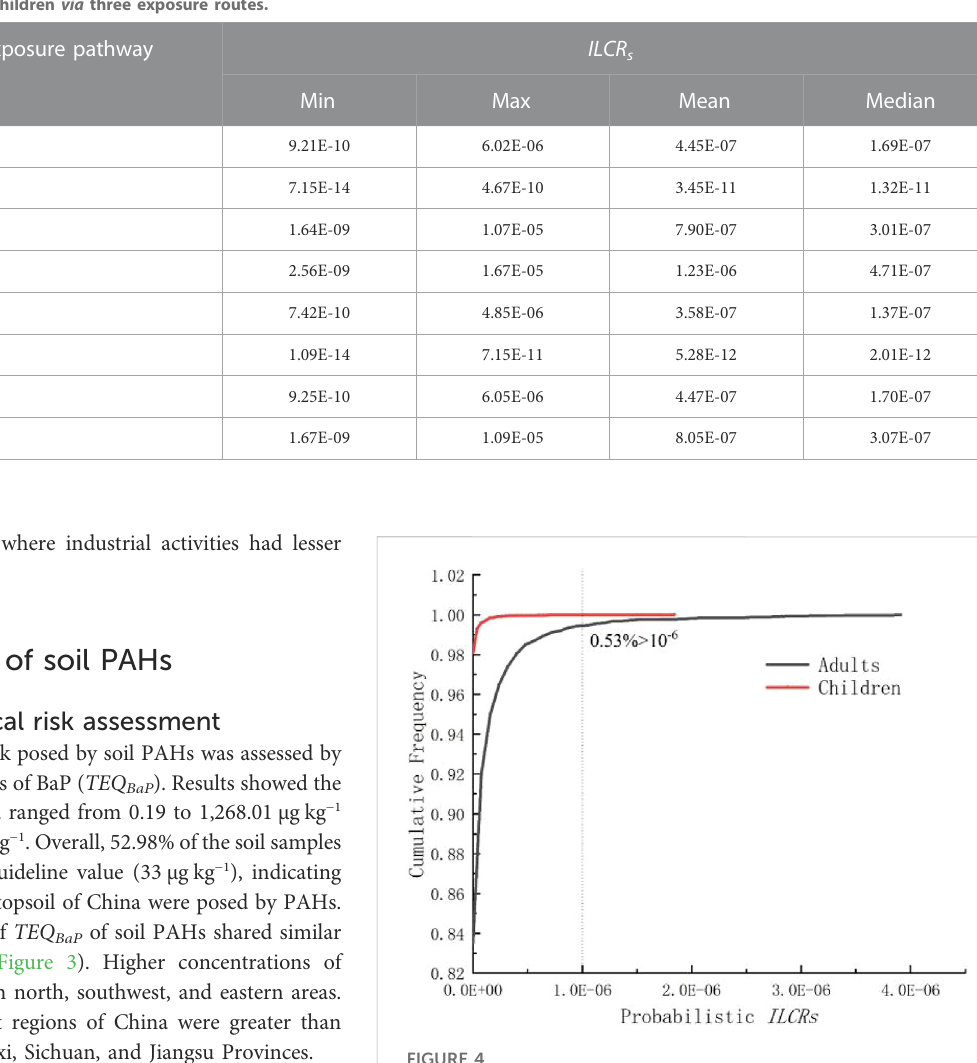
Cumulative frequency of probabilistic ILCR s of adults and